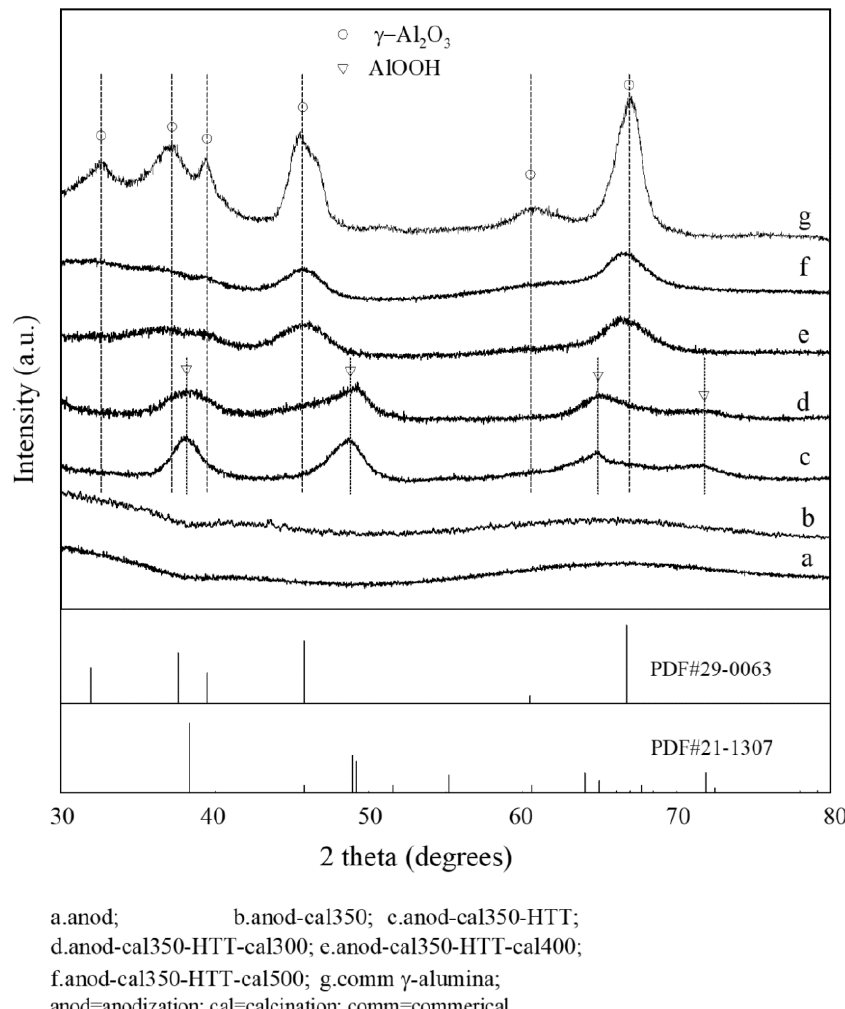
Figure 4. XRD patterns of the PAA materials with different post-treatments.